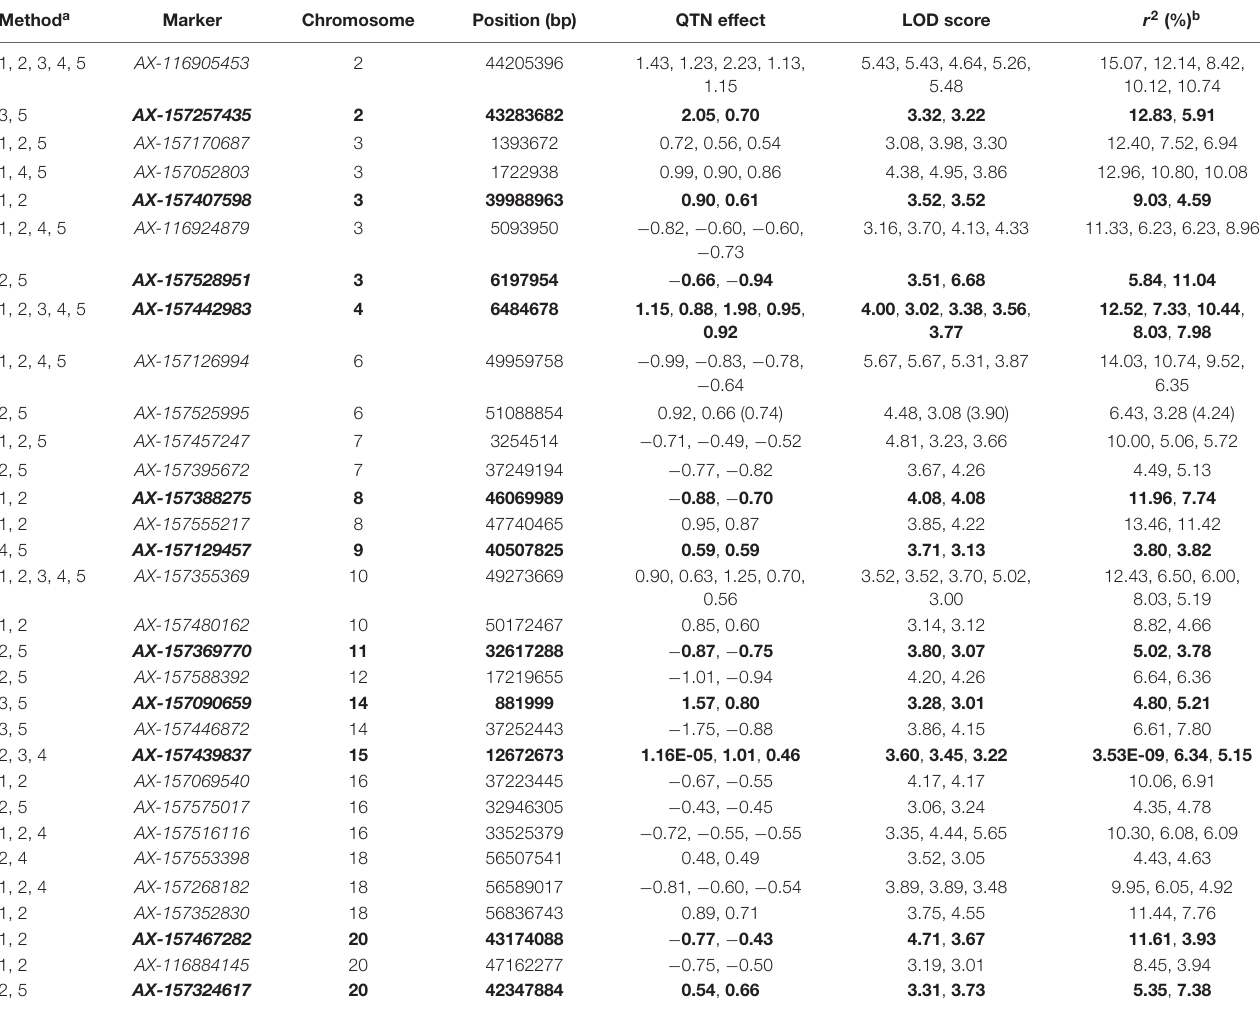
TABLE 3 | Common QTNs for hundred-seed weight in soybean across different multilocus method. Method a